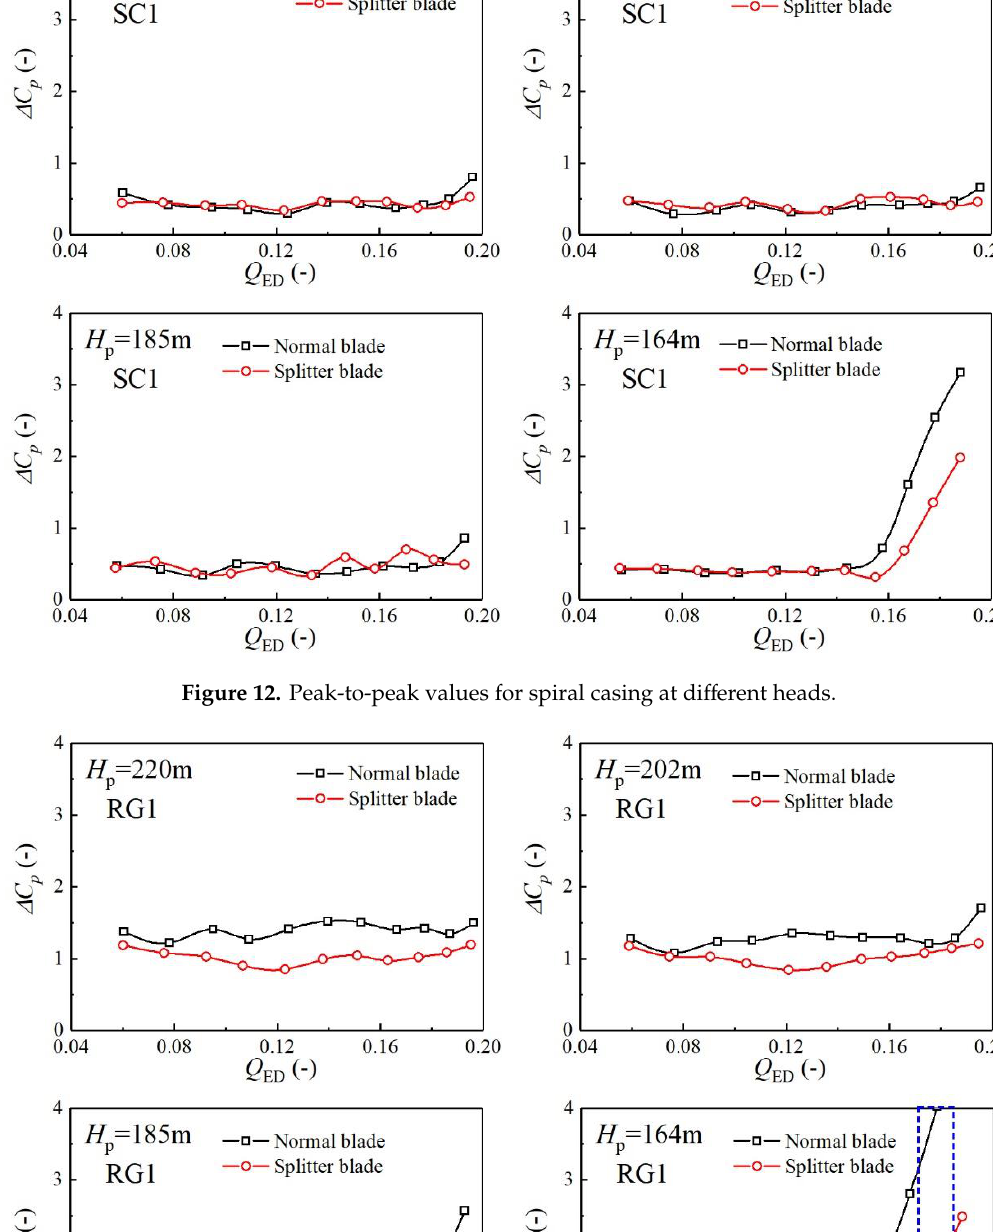
Figure 13. Peak-to-peak values for vaneless space at different heads.